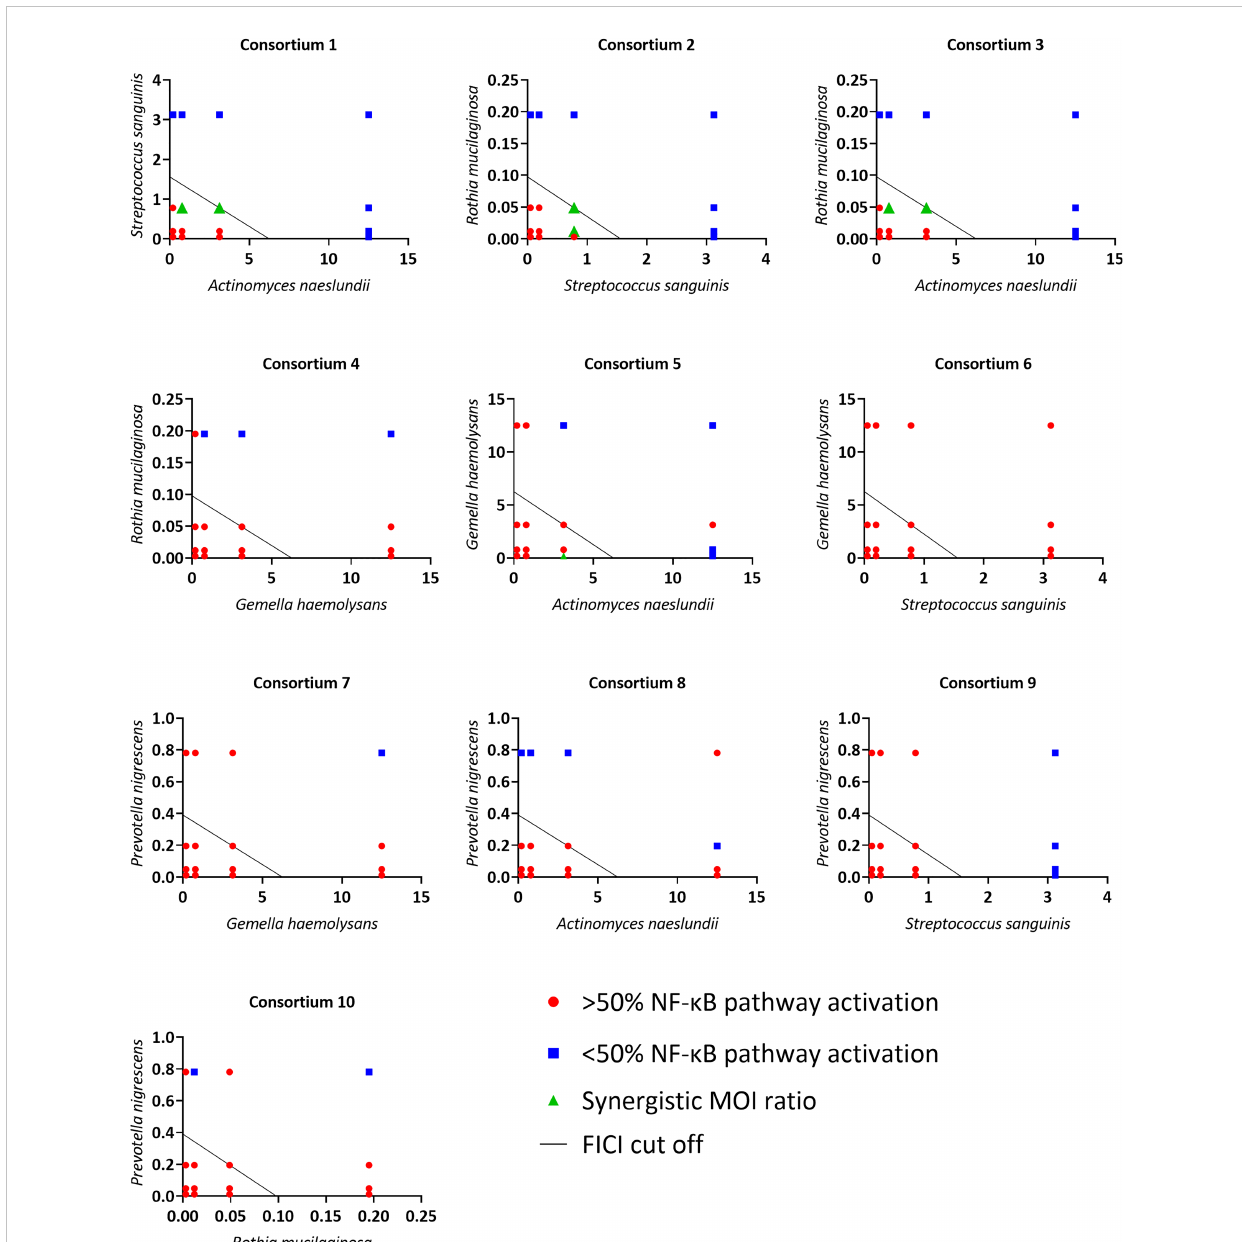
FIGURE 7 Isoboles of all tested consortia to visualize synergistic anti-in fl ammatory activity based on NF- k B pathway activation. On the vertical axis the tested MOI of one commensal species is shown, on the horizontal axis the tested MOI of the other commensal species is shown. MOI ratios were de fi ned as synergistic if:< 50% NF- k B pathway activation compared to LPS-stimulated cells, p< 0.05 and FICI ≤ 0.5. n ≥